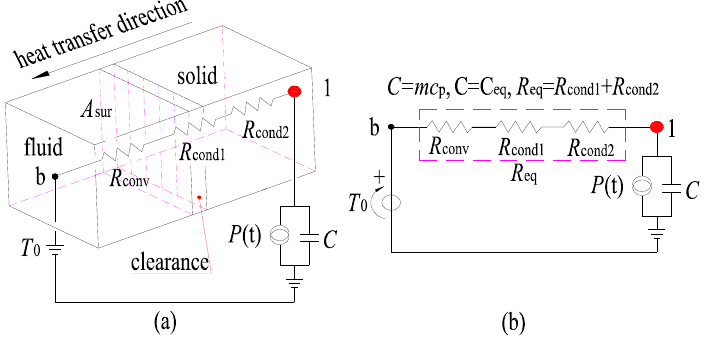
Figure 4. First-order model with air clearance and its thermal network. ( a ) First-order model, ( b ) first-order thermal network.